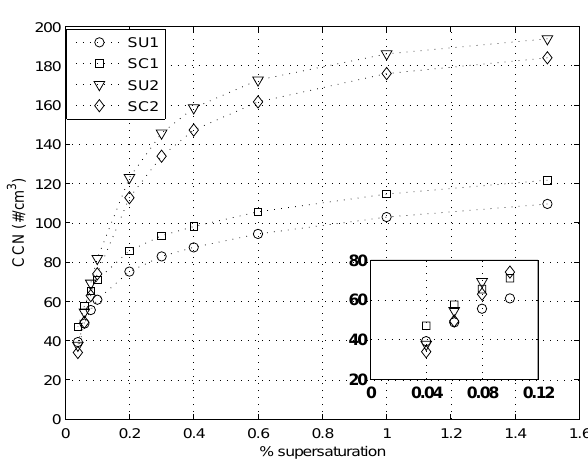
Fig. 4. Cumulative CCN at 1.5% supersaturation for the CBL cir- cles of RICO RF14 excluding the periods of precipitation. Panel (B) shows an expanded scale of (A) .